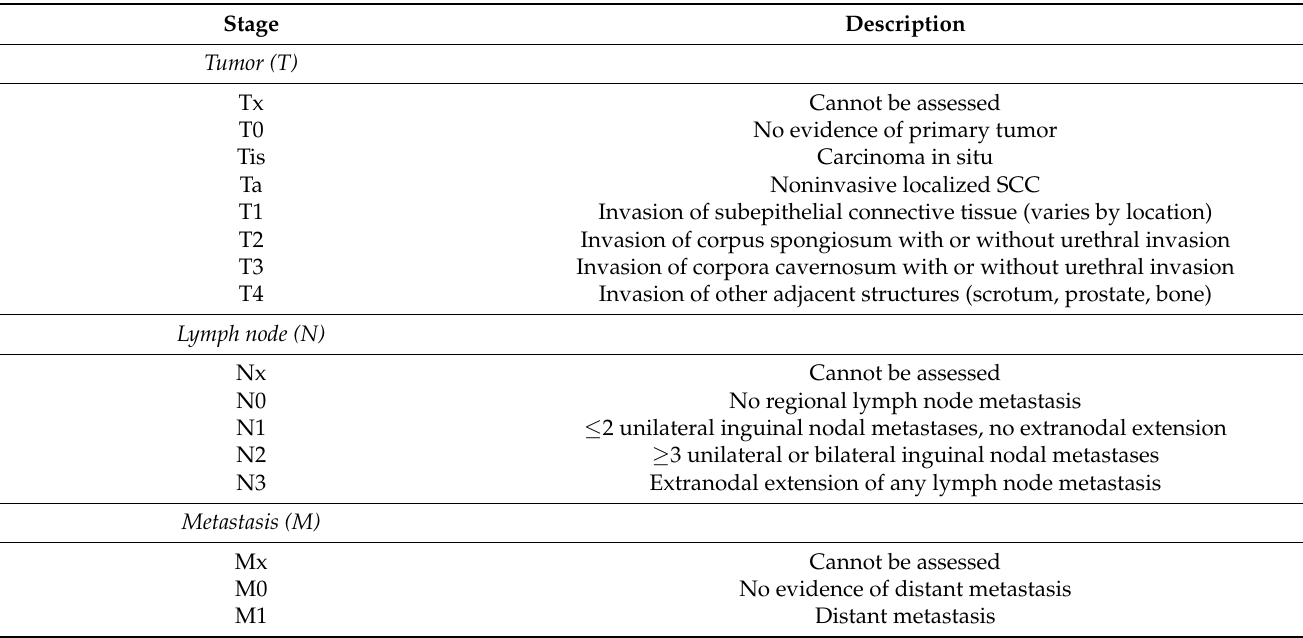
Table 1. American Joint Committee on Cancer 8th Edition TNM Pathologic Staging of Penile Squa- mous Cell